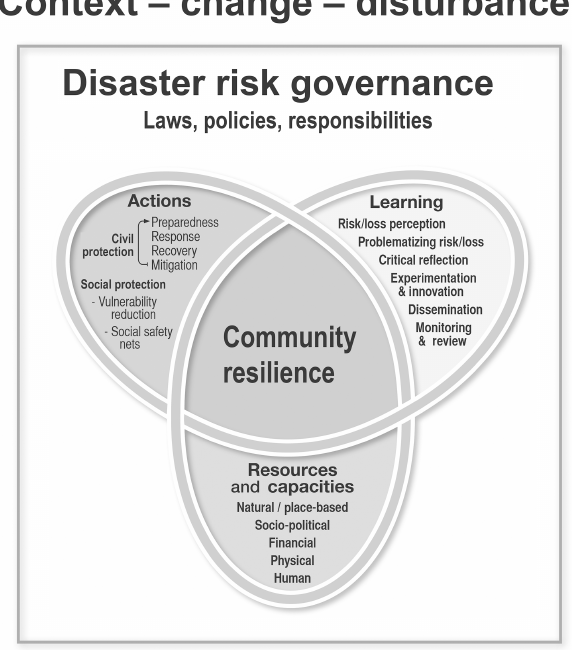
Figure 1. The emBRACE framework for community resilience to natural hazards (source: own